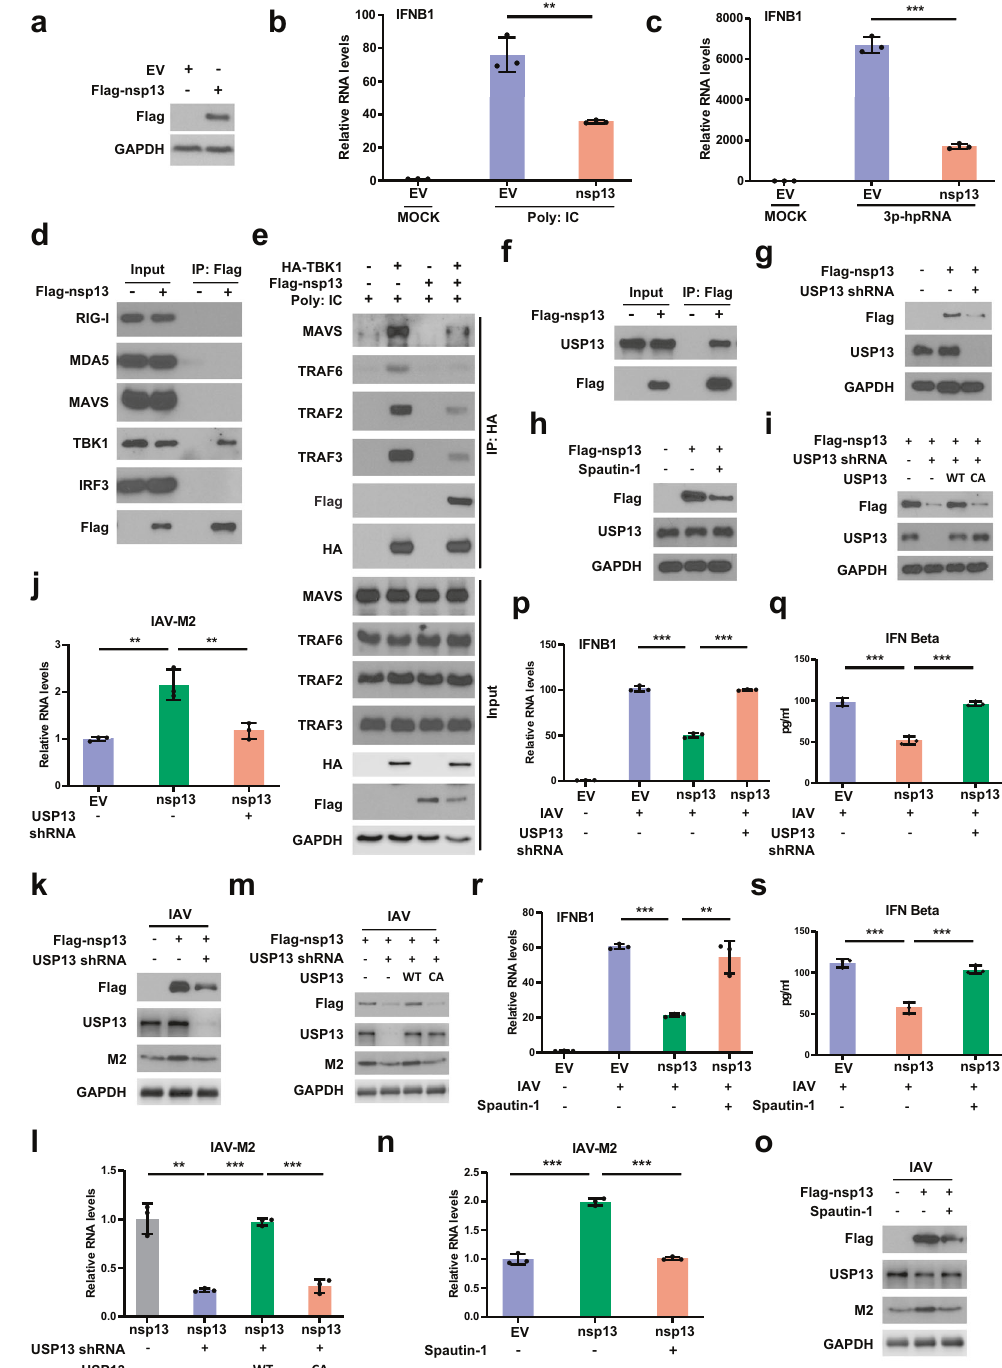
demonstrate that USP13 is hijacked to maintain nsp13 expression and the inhibitory role of nsp13 in regulating type I IFN production, and USP13 inhibitor could be employed to suppress virus replication by targeting nsp13 for degradation thereby disrupting its inhibitory role in regulating type I IFN production. In SARS-CoV-2 nsp13 suppresses RNA virus-induced type I IFN production. Mechanistically, nsp13 interacts with TBK1, and the nsp13 – TBK1 interaction impedes the association of TBK1 with TRAFs and consequent recruitment of TBK1 to MAVS, thereby